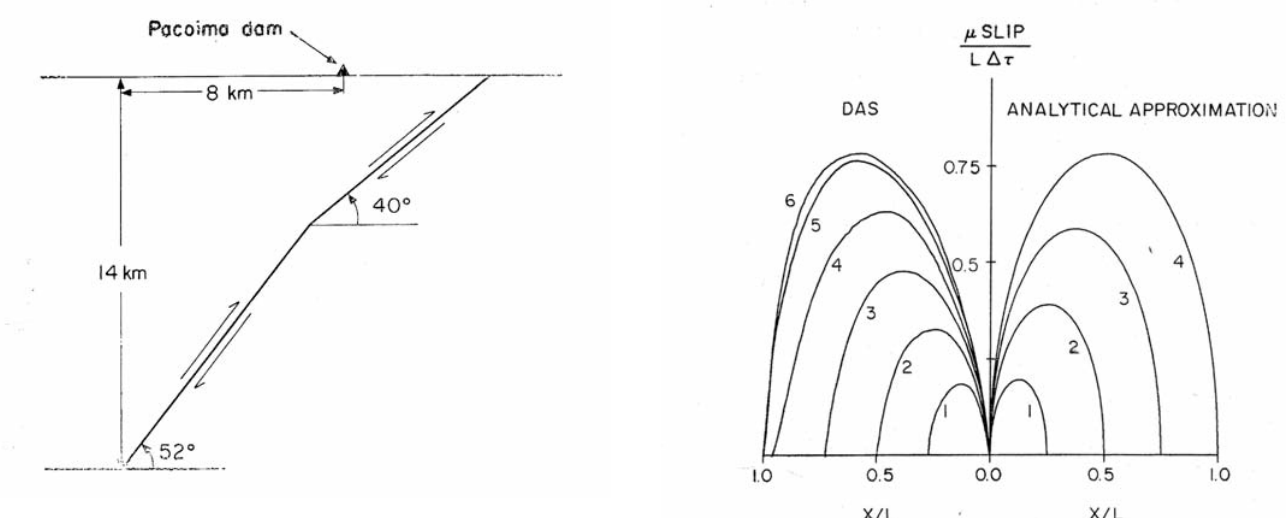
Figure 8. Fault-plane geometry used to model the San Fernando earthquake of 1971 and the site of the strong motion seismograph at Pacoima Dam. Reproduced from Bouchon [1977].